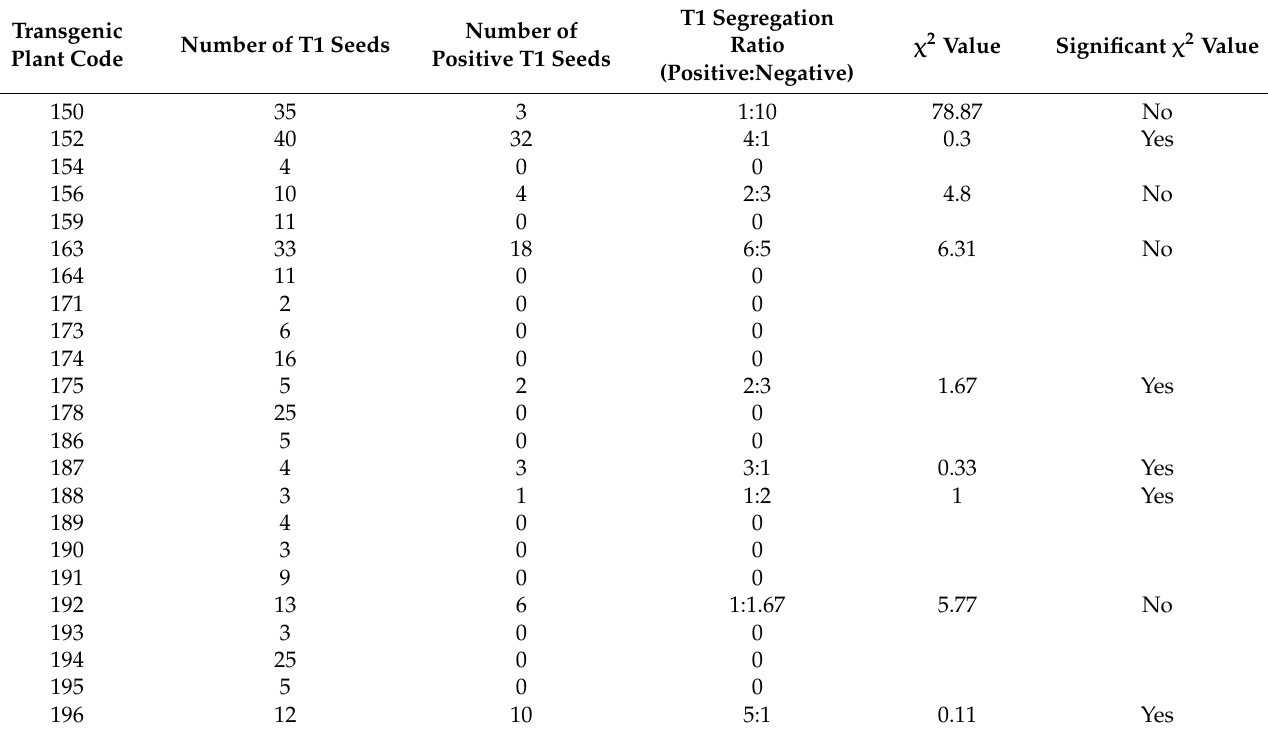
Table 2. The segregation of T1 transformation progeny and chi-squared ( χ 2 ) test